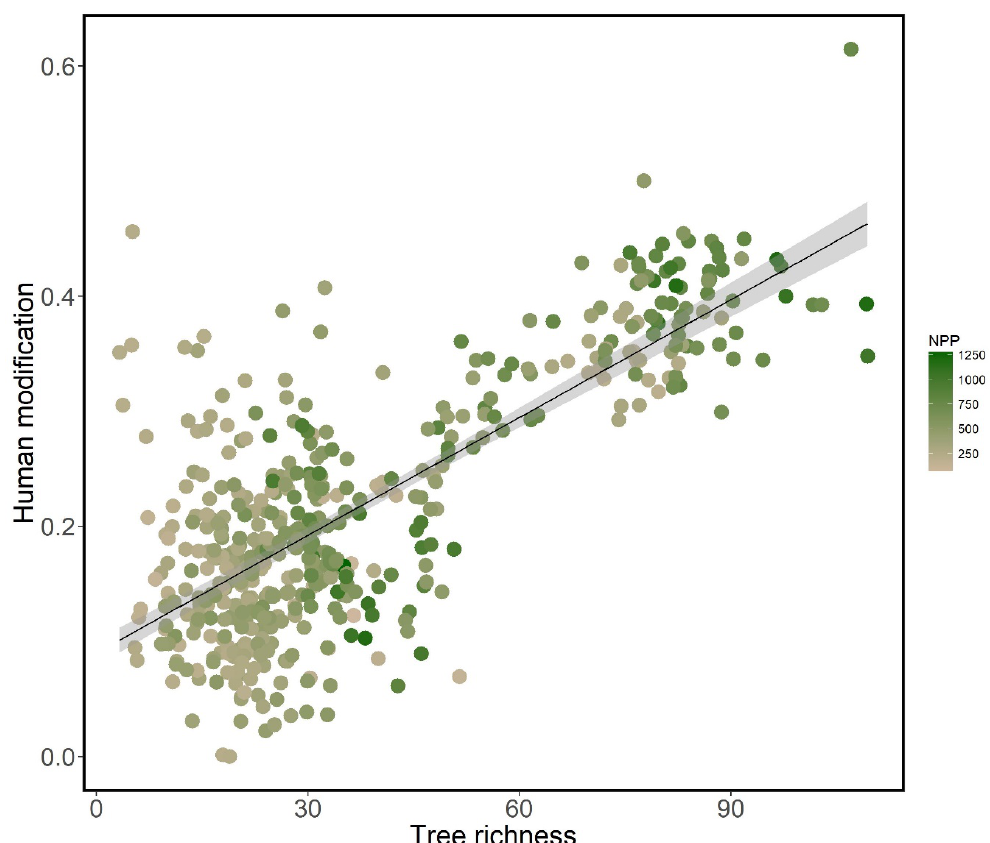
Figure 3. Relationship between average tree richness (predicted number of species based on overlapping species within mapped 10-km grid cells) and the average degree of human modification of USFS ranger districts located in the contiguous US ( N = 492). I added vegetation net primary productivity (NPP; g C m −2 year −1 ) as a color ramp to illustrate additional patterns. The proposed path model fit well the structure of the data (Χ 2 = 1.48; p -value = 0.687; d.f. = 3; RMSEA = 0 with 90% confidence intervals of 0 and 0.058; SRMR = 0.009; CFI = 1.0; TLI = 1.0; Figure 4; Table 1). A p -value > 0.05 from the Χ 2 test provides support for the proposed structure in the path model [29]. Endogenous modeled relationships varied in their degree of explanatory power with models of tree richness and human modification having the highest R 2 values of 0.815 and 0.621, respectively. R 2 values for paths to productivity and conservation protection were lower at 0.286 and 0.170, respectively.